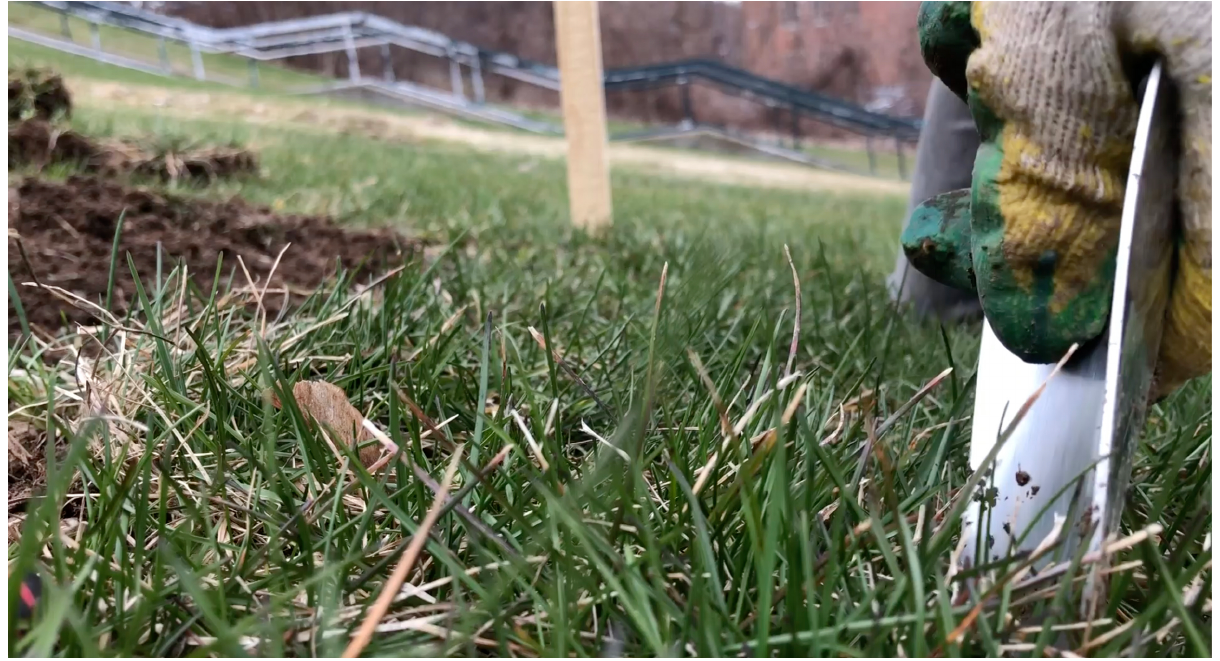
Figure 7: Video documentation of the establishment of Lawn Lab plot #2 at the western edge of RPI’s campus near downtown Troy in March 2018. This plot was sited on a large lawn that had been converted from forested land within the last